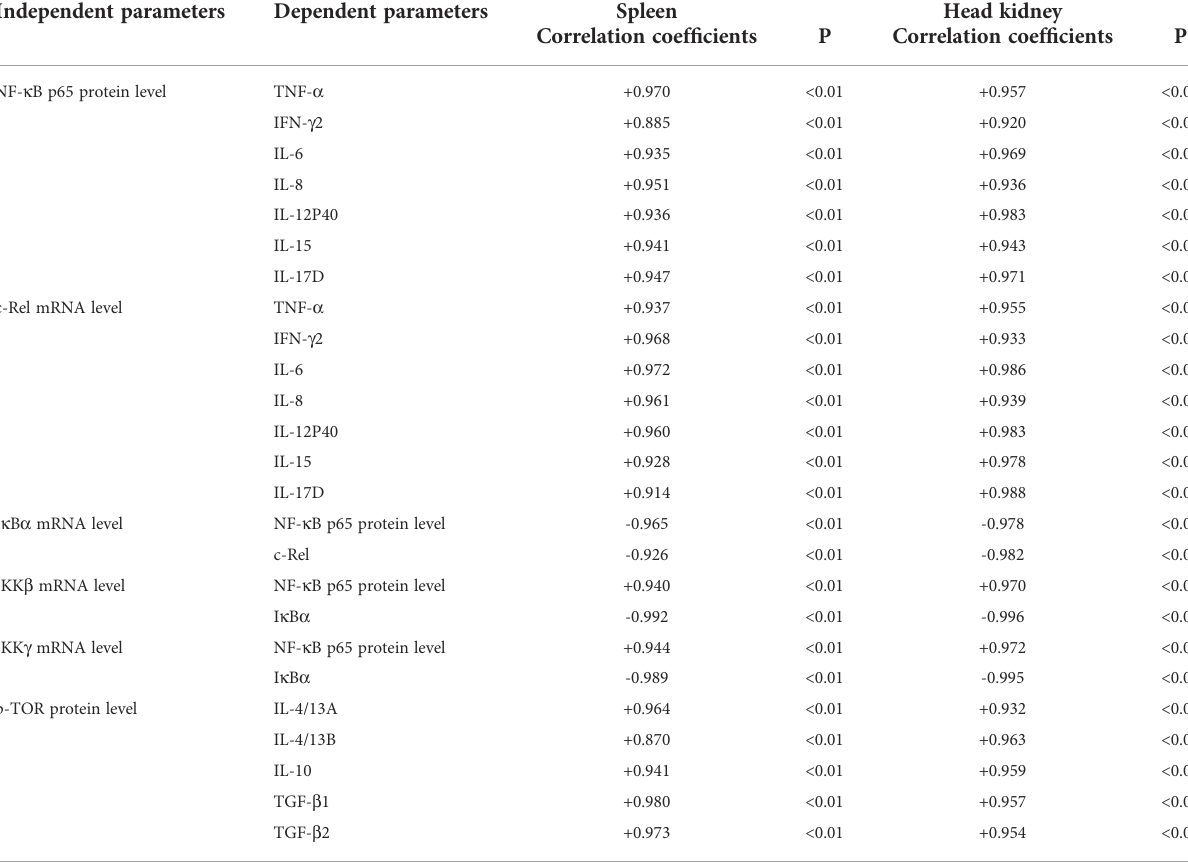
TABLE 2 Correlation coef fi cient of parameters in the immune organs of grass carp 1